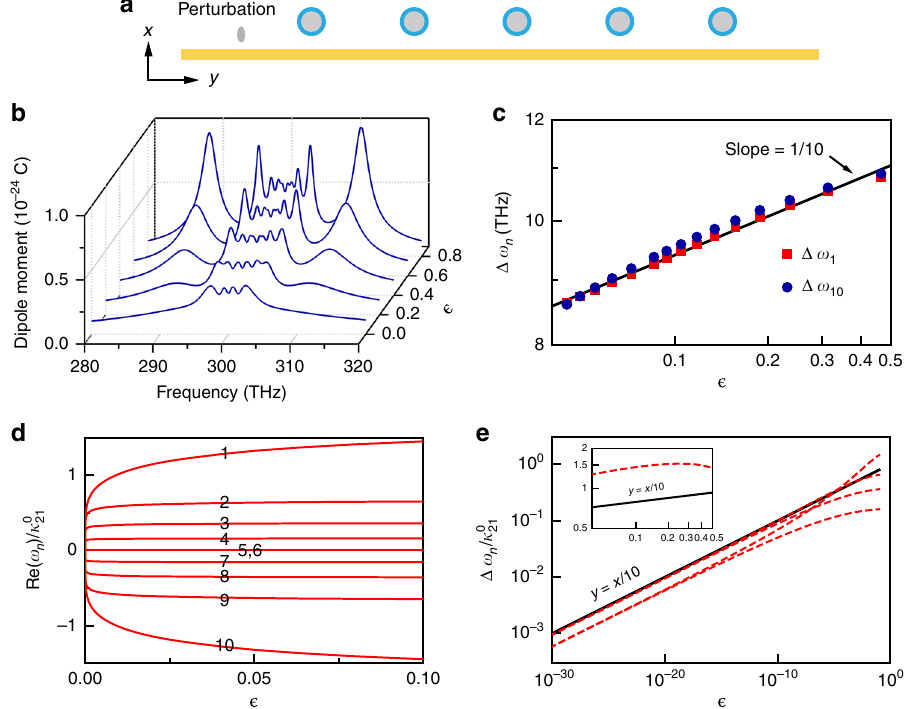
Fig. 4 Enhancement of sensitivity by the higher-order exceptional point. a Two-dimensional model system consisting of fi ve cylinders on a plasmonic waveguide. The spacing between cylinders is 5 λ plas . A cylinder of elliptical shape is used to induce perturbation. b Total dipole moment of the cylinders as a function of frequency for different perturbation ϵ . c Frequency splitting Δ ω n = | ω n − ω 0 | as a function of perturbation strength for n = 1 and n = 10, corresponding to the fi rst and the last peaks in b . They follow a trend with a slope of 1/10 in the log – log plot. d Real parts of the normalised eigenvalues as a function of perturbation strength, obtained with the Hamiltonian in Eq. (5). e Normalised frequency splitting as a function of perturbation strength for the eigenvalues in d . When ϵ is small, all Δ ω n = κ 0 follow the line of y = x /10. The inset shows a zoom-in of the large perturbation range for Δ ω 1 = κ 0 21 (cid:9) T . Figure 4d shows the real parts of = κ 0 the normalised eigenvalues ω as a function of perturbation n 21